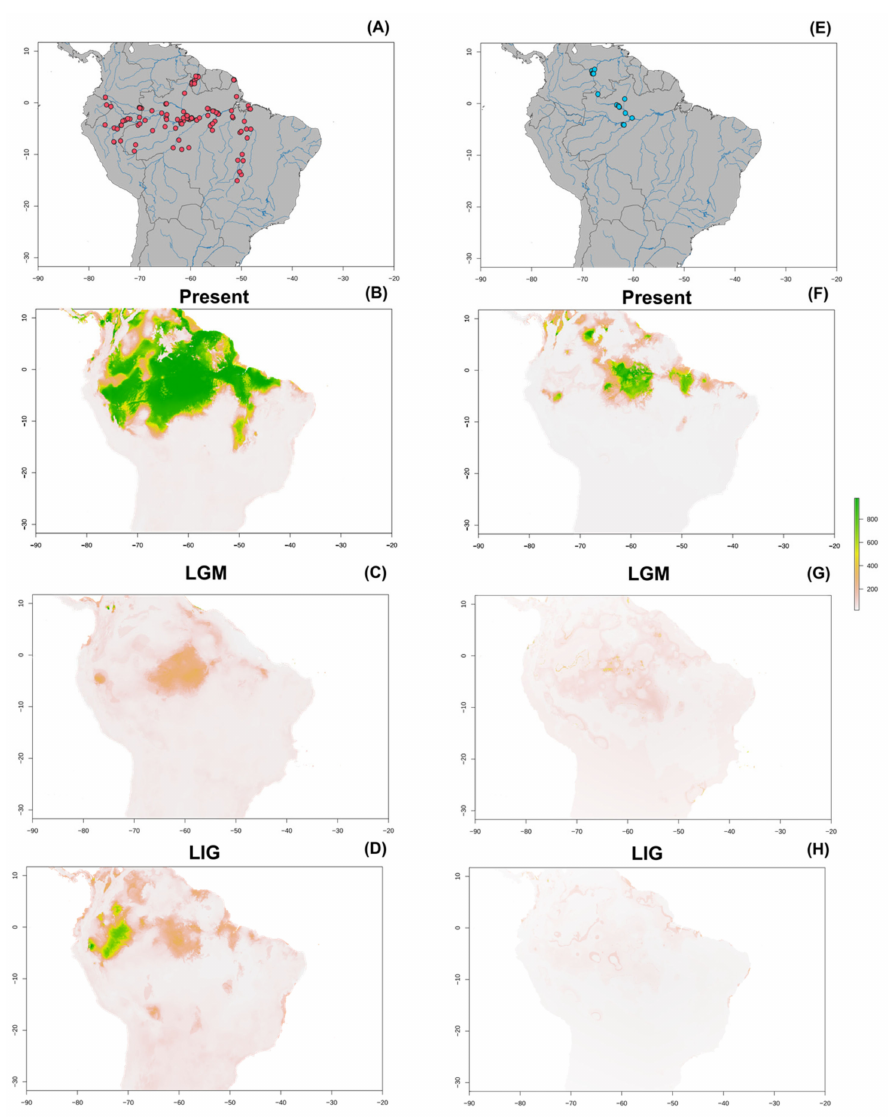
Figure 7. ( A ) Climatic niche modeling in O. bicirrhosum according to registered occurrences. Appropriate climatic regions are evidenced by gradient colors for present ( B ), last glacial maximum ( C ) and last interglacial ( D ). ( E ) Climatic niche modeling in O. ferreirai according to registered occurrences. Appropriate climatic regions are evidenced by gradient colors for present ( F ), last glacial maximum ( G ) and last interglacial ( H ). Colors refer to environmental suitability, with green representing high and orange low to moderate